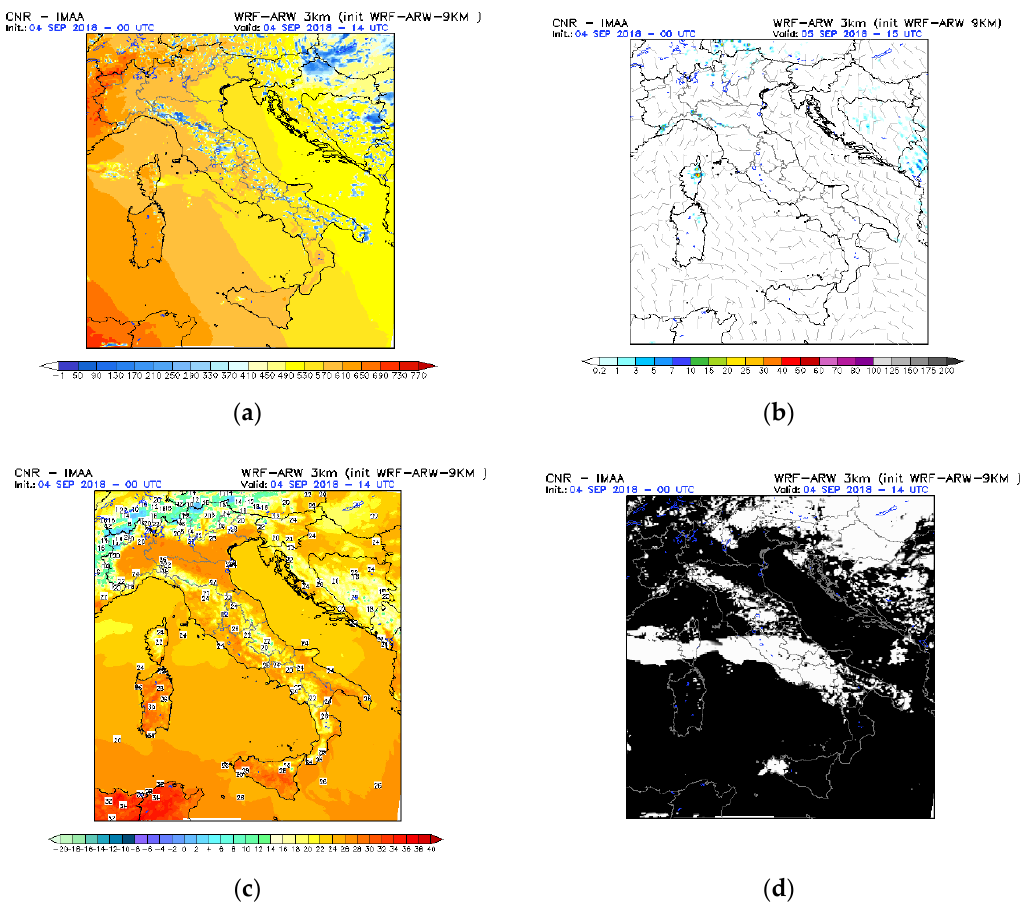
Figure 2. Example of IMAA-CNR WRF products. Run of 04/09/18 at 00:00 UTC, forecast valid at 14:00 UTC on 04 September 18. Variables forecasted: ( a ) global horizontal irradiance (W/m 2 ), ( b ) 3 h cumulated total precipitation (mm/3 h) plus wind speed (knots) and direction, ( c ) surface temperature (°C), ( d ) cloud cover.